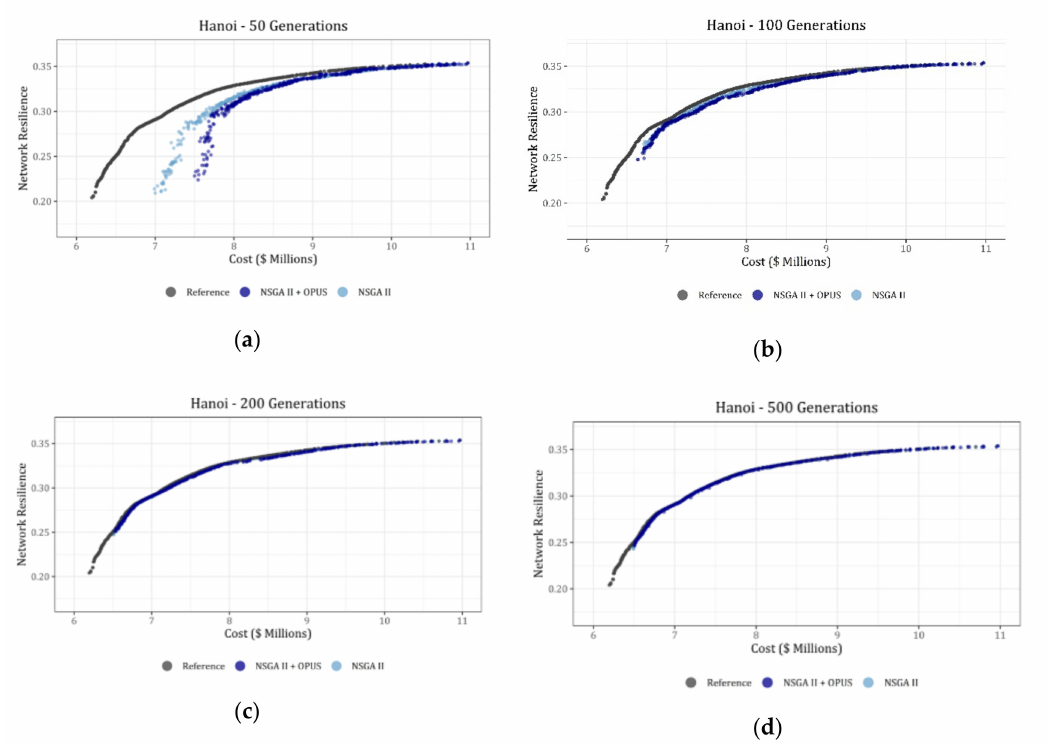
Figure 2. Evolution of the PFs for the non-dominated sorting-based multi-objective evolutionary algorithm (NSGA-II) algorithm (light blue) and the retrofitted NSGA-II with optimal power use surface (OPUS) (dark blue) in comparison to the best-known PF (black) for Hanoi. ( a ) 50 generations; ( b ) 100 generations; ( c ) 200 generations and ( d ) 500